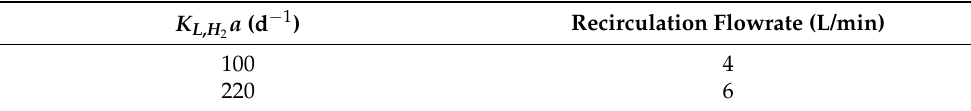
Figure 3. Experimental data fitting related to the composition of ( a ) hydrogen, ( b ) methane and ( c ) carbon dioxide and to ( d ) the outlet biogas flowrate. At day 7 the inlet flowrate of hydrogen in the system was switched from 10 mL/min to 50 mL/min, and the recirculation biogas flowrate was switched from 4 L/min to 6 L/min. Table 6. Fitted value of the hydrogen mass transfer coefficient depending on the different recirculation flowrate.